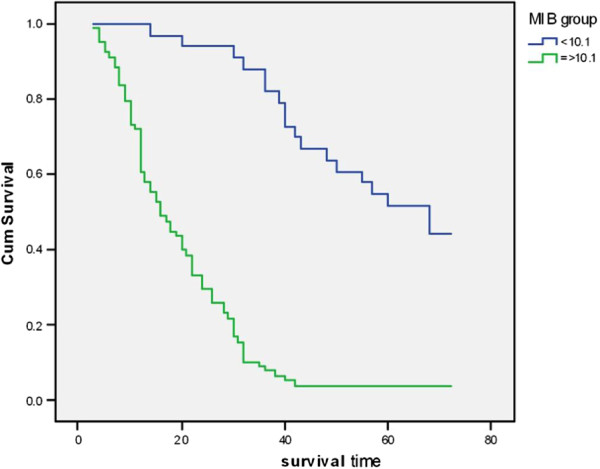
Kaplan-Meier overall survival curves for tumors with MIB-1 LI < 10.1 and MIB-1 LI ≥ 10.1.